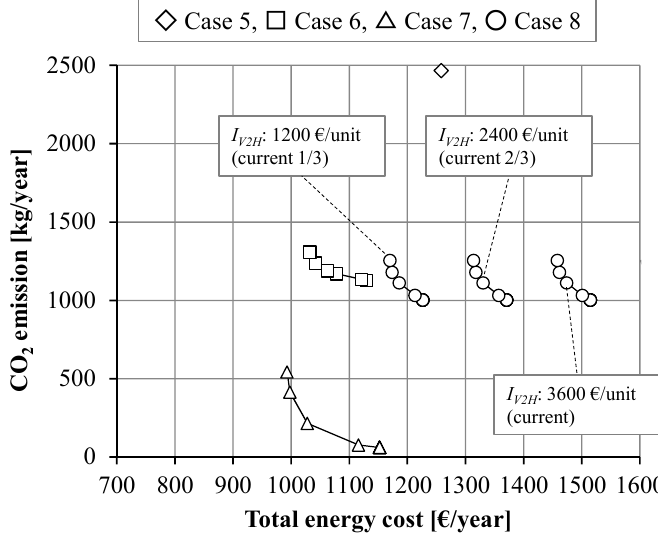
Figure 14. Pareto solution of the cost and amount of CO 2 emission for the cases of commuter EV.